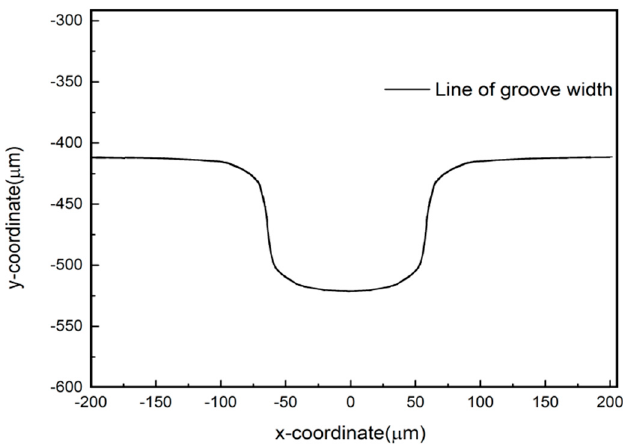
Figure 5. The profile of the groove width when the machining time is 30 min.